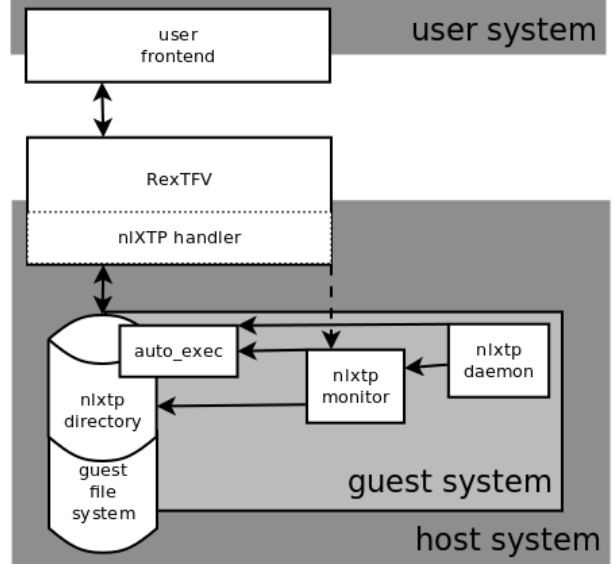
Figure 3. Components of RexTFV using nlXTP,